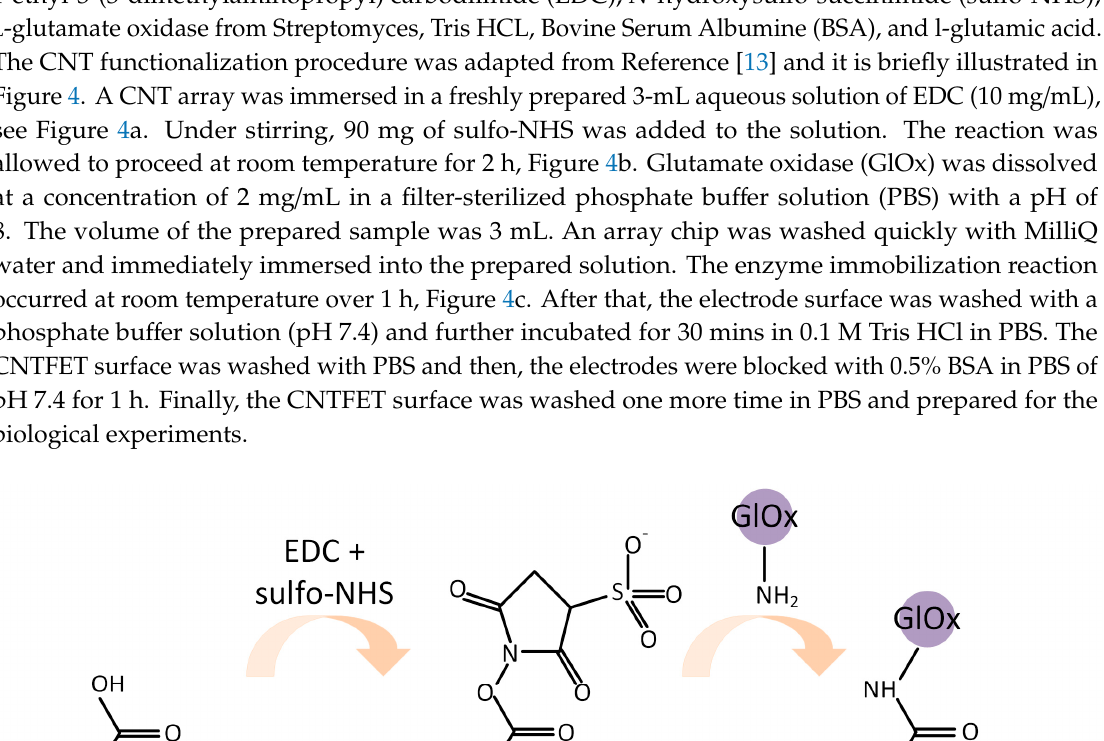
Figure 3. ( a ) Physical map of 8007 CNT-bridged electrode pairs as obtained from electrical conductance tests, ( b ) Histogram of resistance values across the whole array.